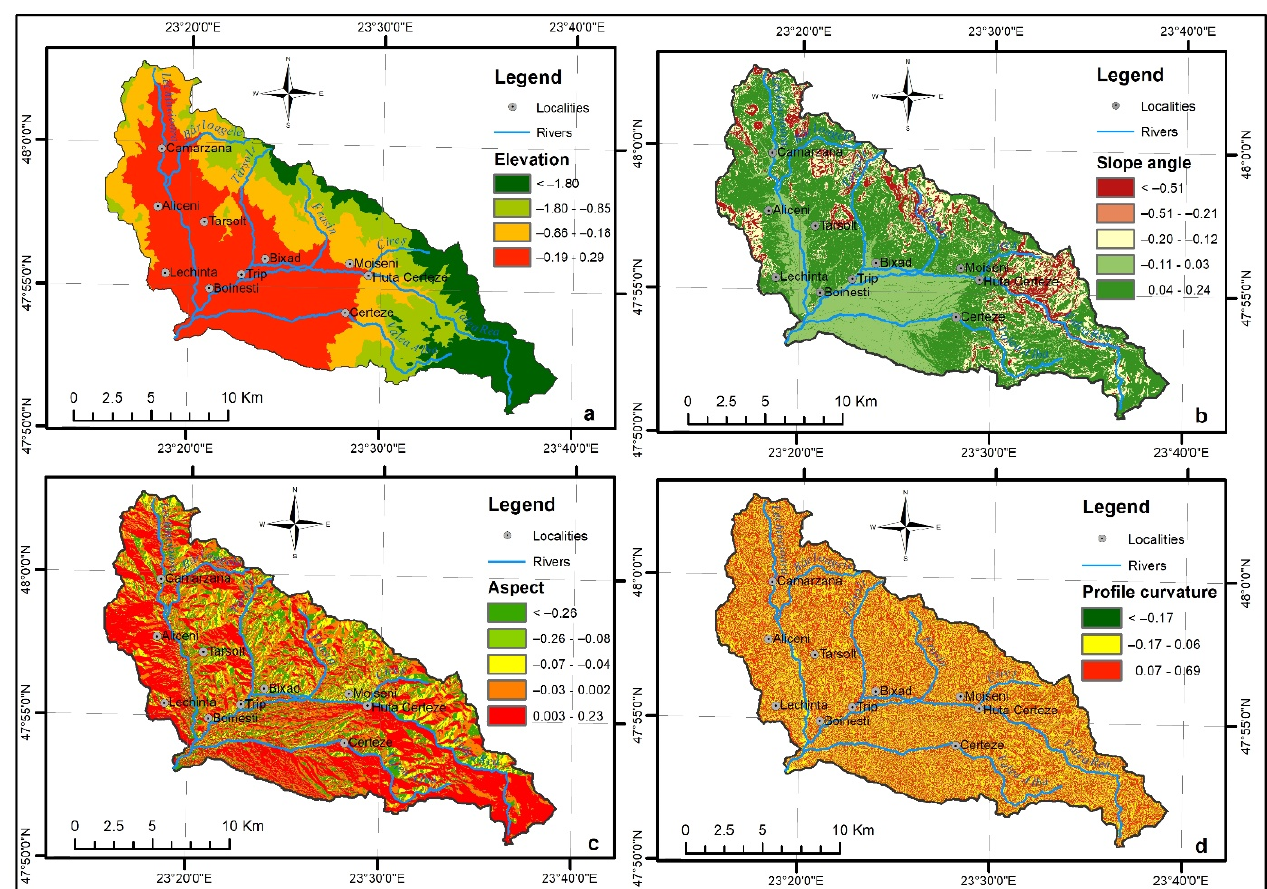
Figure 3. ( a ) Elevation, ( b ) Slope angle, ( c ) Aspect, ( d ) Profile curvature.